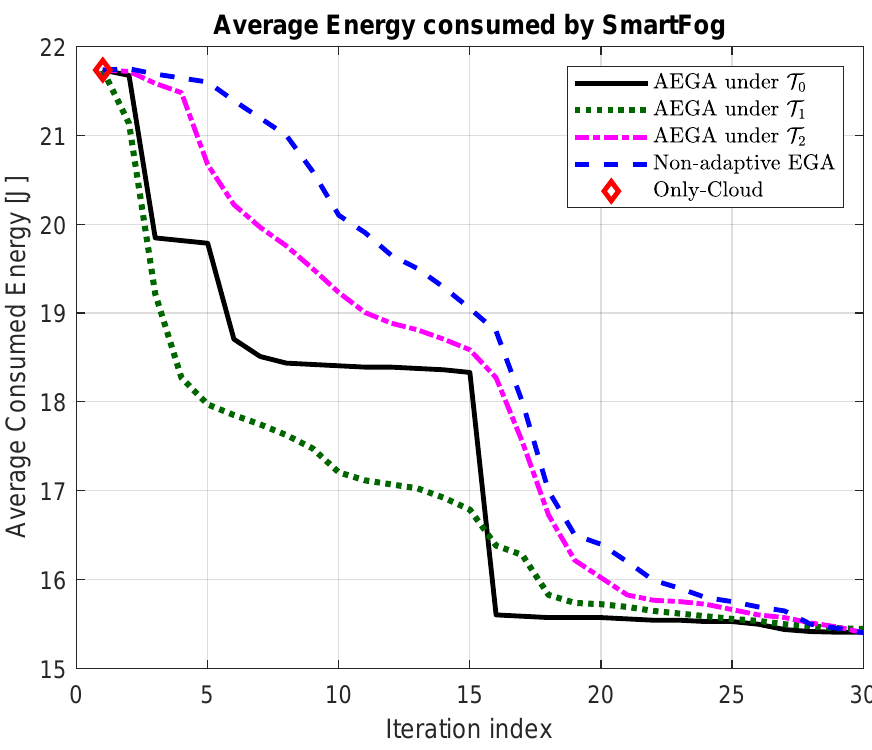
Figure 3. Average energy consumption of the simulated SmartFog platform of Figure 1 for the training of the 3L-SDAE under the: AEGA with the optimized inter-threshold T 0 (continuous black curve), AEGA with the inter-threshold T 1 (dotted dark green curve), AEGA with the inter-threshold T 2 (dash-dotted magenta curve), NA-EGA (dashed blue curve) and only-Cloud (red diamond) mapping